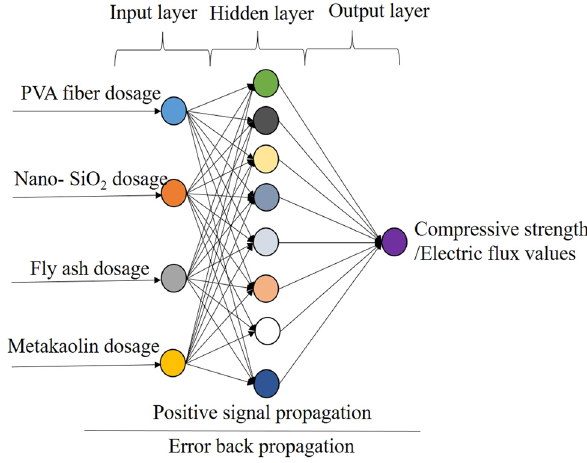
Figure 1: Structure of BP neural network.